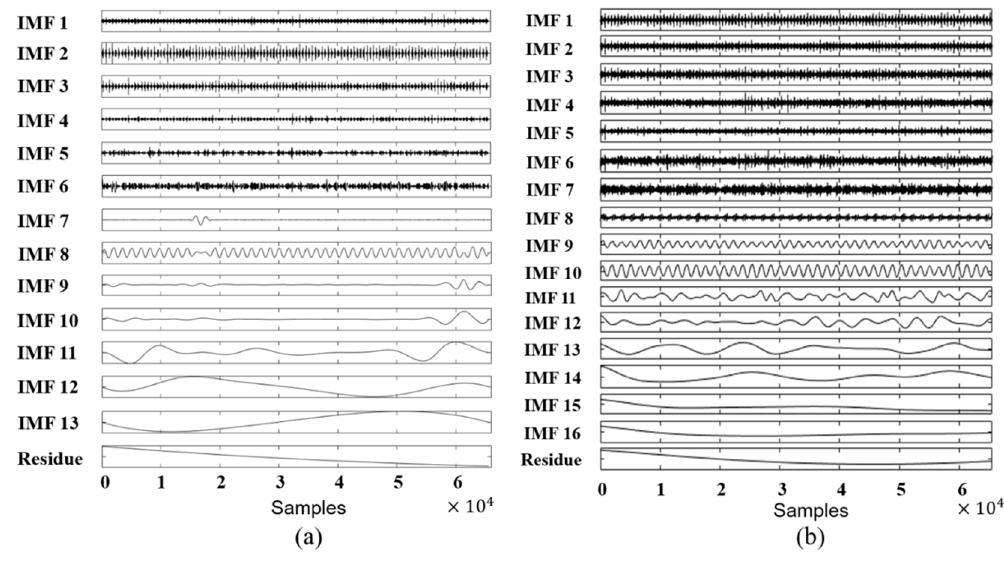
Figure 4. Decomposition of a one-second intensive rubbing signal by ( a ) EMD and ( b ) EEMD.